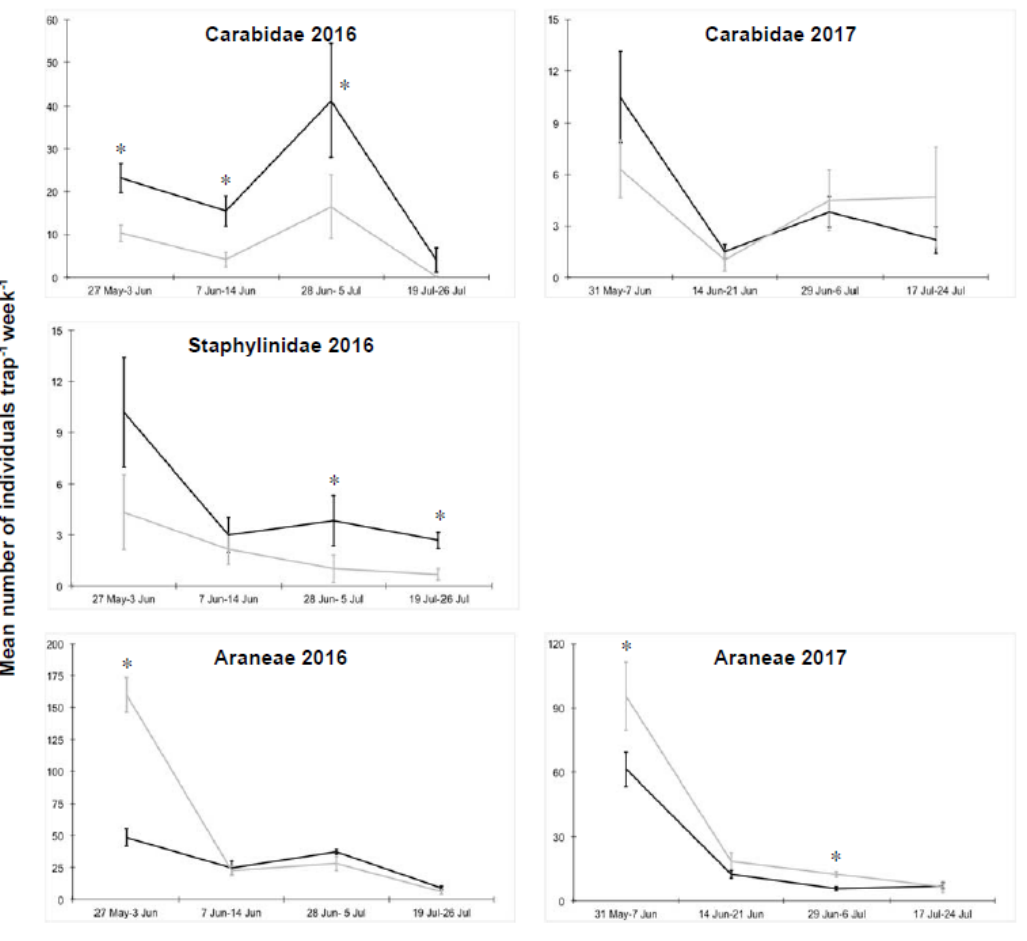
Figure 3. Abundance of individual Carabidae, Staphylinidae, and Araneae collected in the experimental plots of tomato, where the cover crops were terminated either with a roller crimper (IL-RC, black line) or through green manuring (GM, grey line). Vertical bars represent standard errors of the means; * = significant differences within each sampling date as detected by the generalized linear mixed model. Note that ordinate scales differ among the charts.